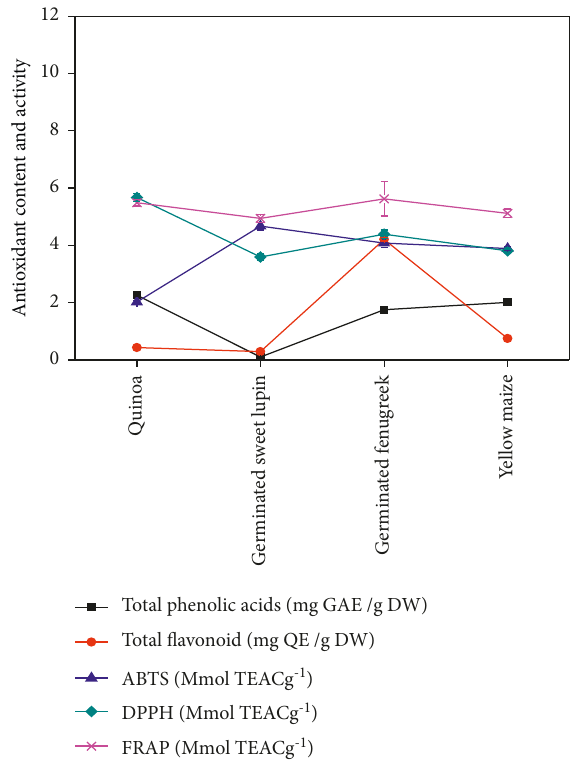
Figure 2: Antioxidant content and activities of raw